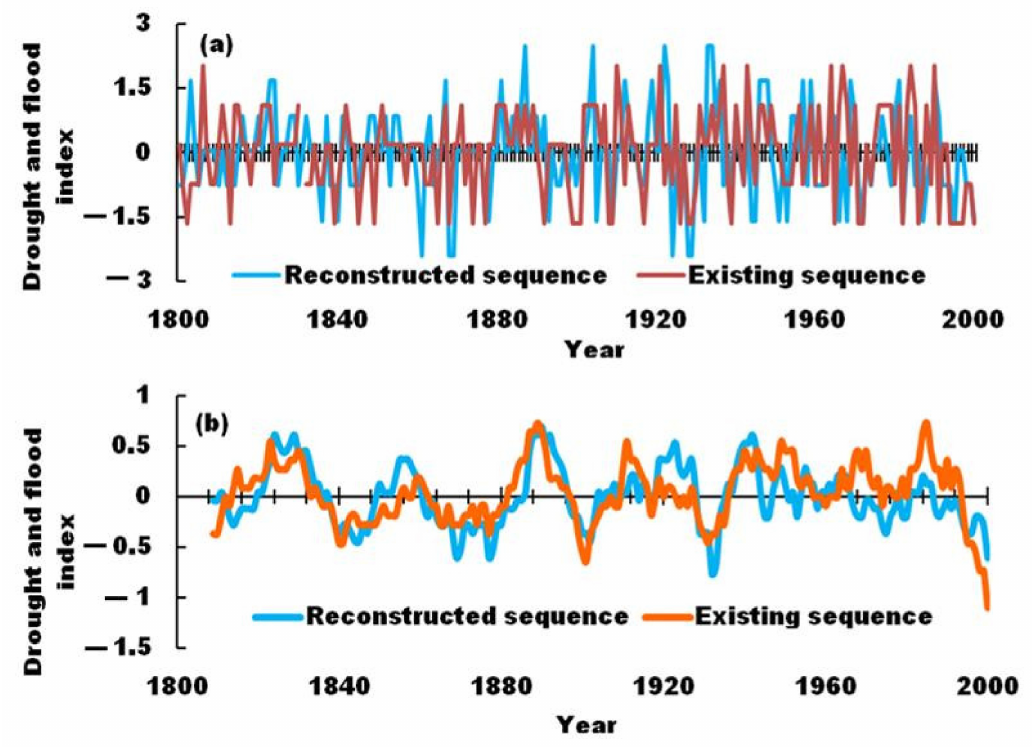
Figure 3. Comparison of reconstructed drought and flood sequences in the upper reaches of the Weihe River Basin with existing drought and flood sequences. ( a ): Original sequence; ( b ): 10-year sliding